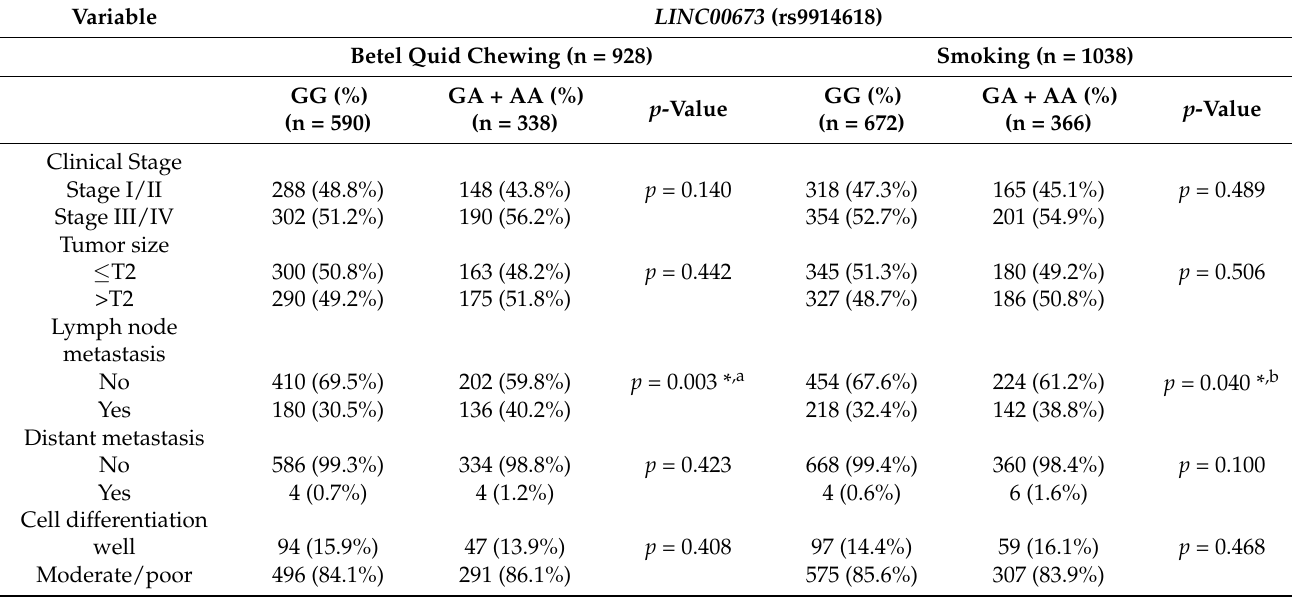
Table 4. Clinical statuses and LINC00673 rs9914618 genotype frequencies in oral cancer among 928 betel quid chewing and 1038